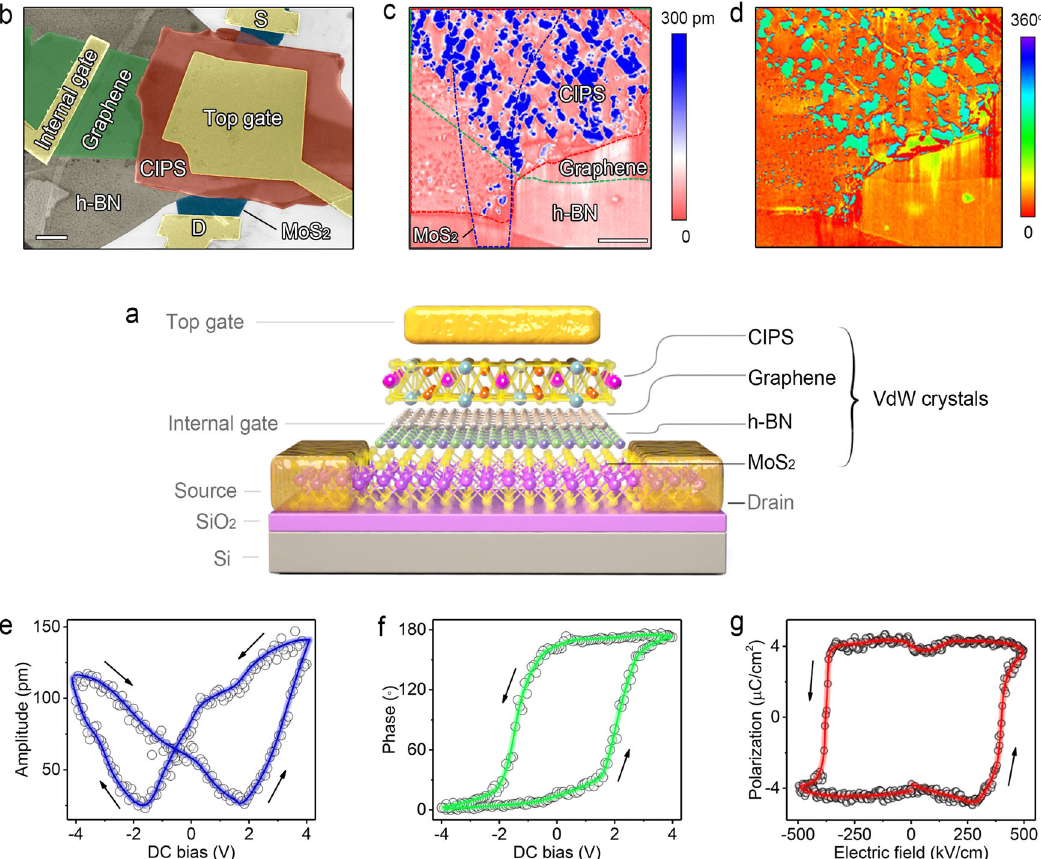
Fig. 1 All-vdW FeFET. a Schematic diagram of an MoS 2 /h-BN/graphene/CIPS vdW FeFET. A ferroelectric CIPS capacitor is integrated onto the gate of the 2D FET, with MoS 2 as the channel material, h-BN as the gate dielectric and graphene as the gate contact, to realize the vdW FeFET with an MFMIS structure. b False-color SEM image of a typical vdW FeFET. Scale bar, 2 μ m. c , d PFM amplitude c and phase d image of an MoS 2 /h-BN/graphene/CIPS vdW heterostructure. MoS 2 , graphene, and CIPS are indicated by the blue, green, and red dashed lines, respectively. Scale bar, 2 μ m. e , f The off- fi eld PFM amplitude e and phase f hysteresis loops during the switching process for the CIPS fl ake. g The P − E hysteresis loops of a 200-nm-thick CIPS parallel-plate capacitor at 1